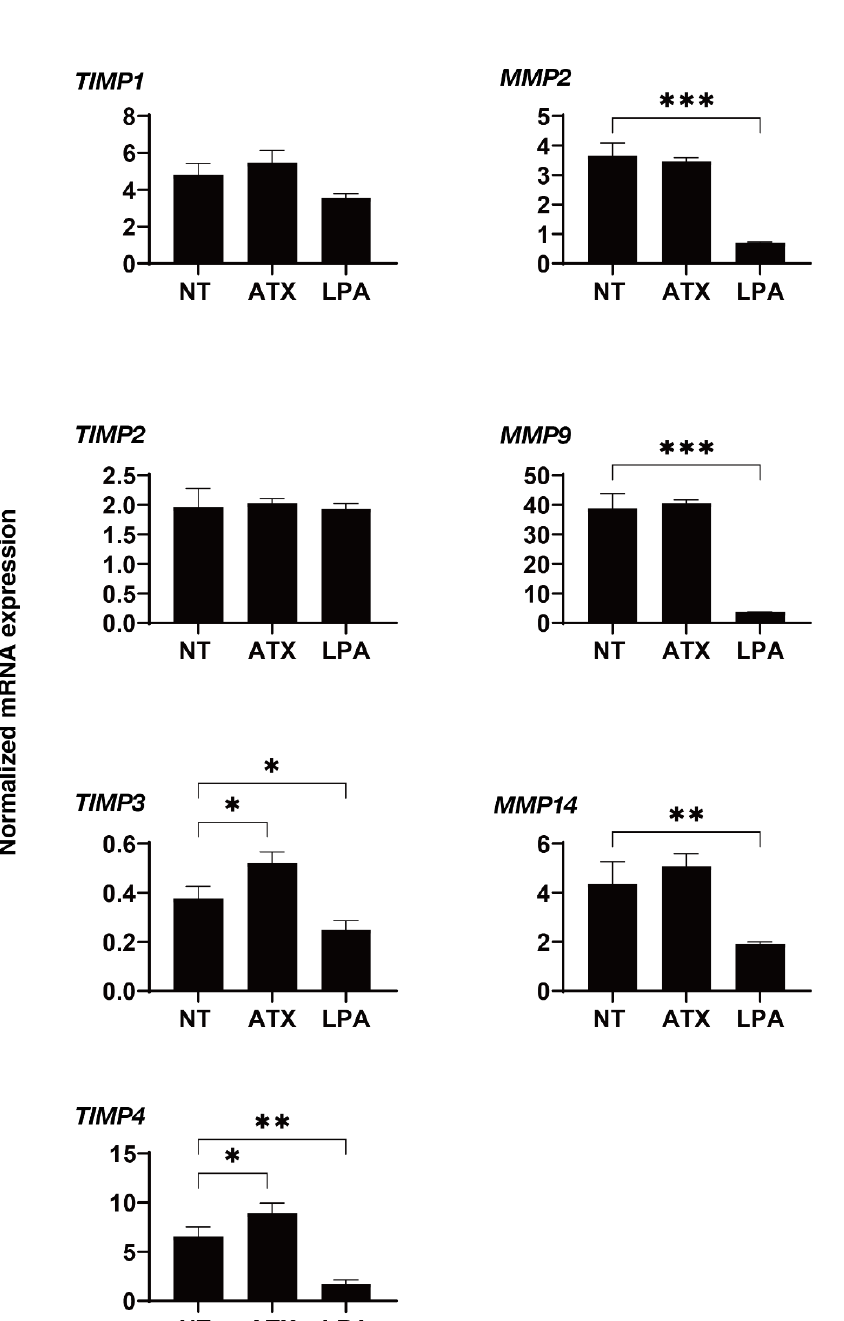
Figure 5. mRNA expression of TIMPs and MMPs in 3D cultured HTM cells. During the 6-day culture of the 3D HTM spheroids, 2 mg/L ATX or 200 nM LPA was exposed during Day 5 through 6, and the mRNA expression of TIMP1-4 , and MMP2 , 9 and 14 were measured. All experiments were performed in duplicate using fresh preparations. NT; untreated control. Data are presented as the arithmetic mean ± standard error of the mean (SEM). * p < 0.05, ** p < 0.01, *** p < 0.005 (ANOVA followed by Tukey’s multiple comparison test). TIMP; tissue inhibitor of metalloproteinase, MMP; matrix metalloproteinase.